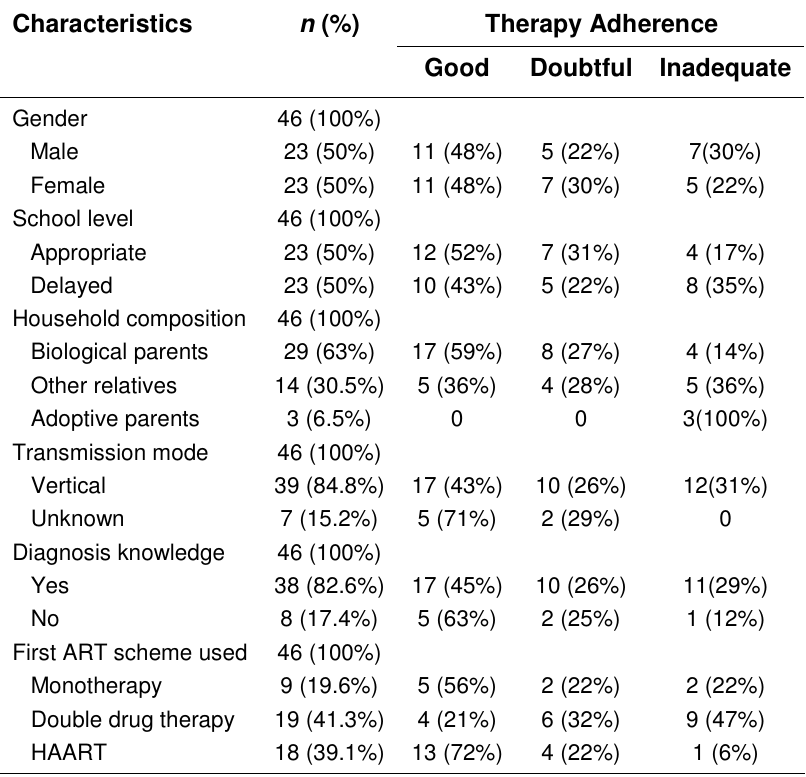
Characteristics of Patients in Each Therapy Adherence Level Characteristics n (%) Therapy Adherence